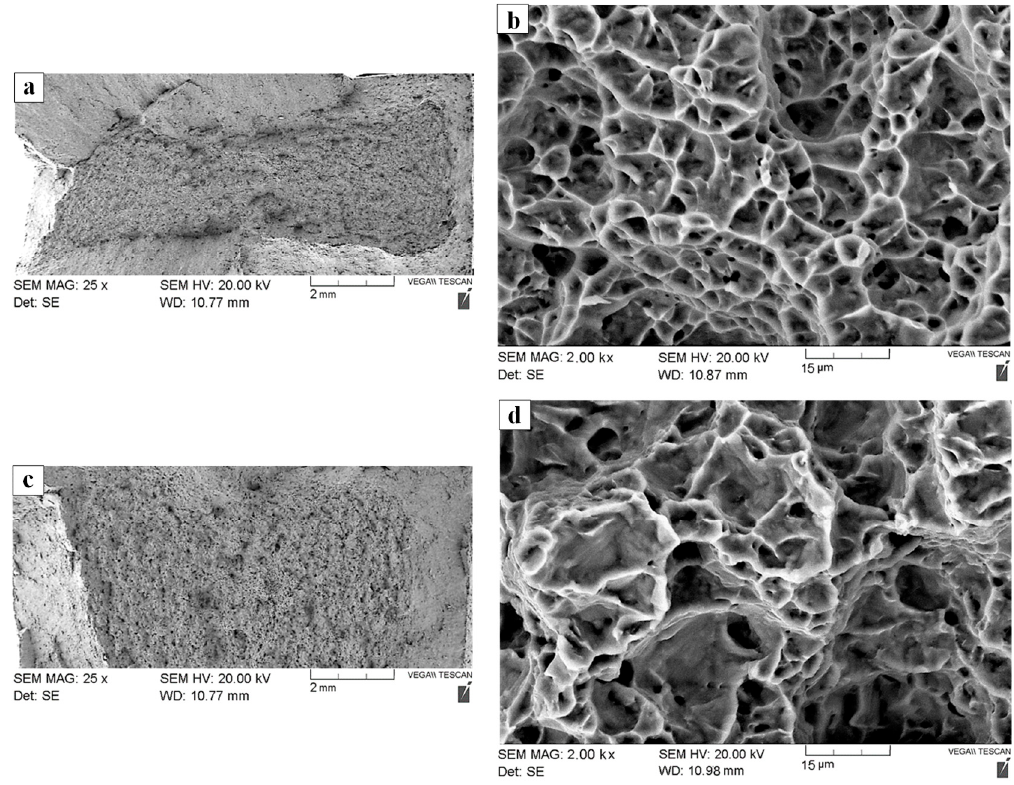
Figure 13. Tensile fracture surface SEM images ( a ) AWed overview; ( b ) AWed magnified; ( c ) SRAed overview; ( d ) SRAed